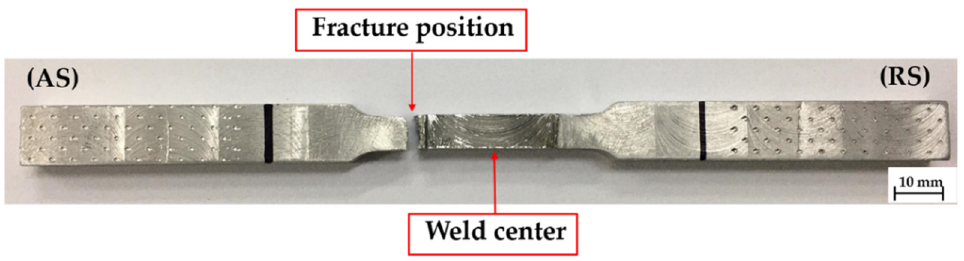
Figure 11. Fracture specimen of tensile test for a rotational speed of 1200 rpm, a welding speed of 10 mm/min, and with a threaded cylindrical tool pin profile.